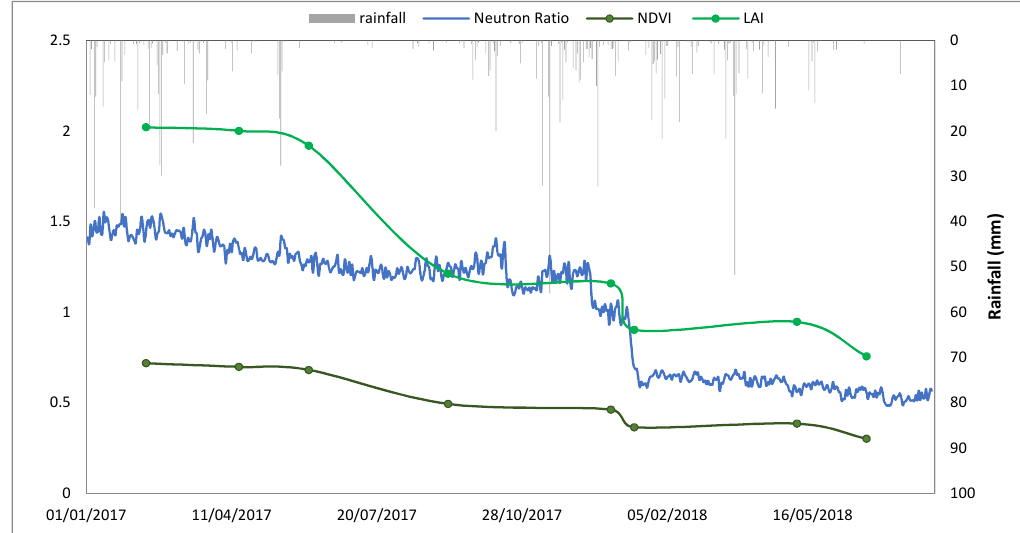
Figure 10. Daily neutron ratio of the ground CRNS, NDVI, and LAI in the Two-Streams Catchment from January 2017 to August 2018. Scatterplots of the neutron ratio (x-axis) and NDVI (y-axis), and neutron ratio (x-axis) and LAI (y-axis) are illustrated in Figure 11.